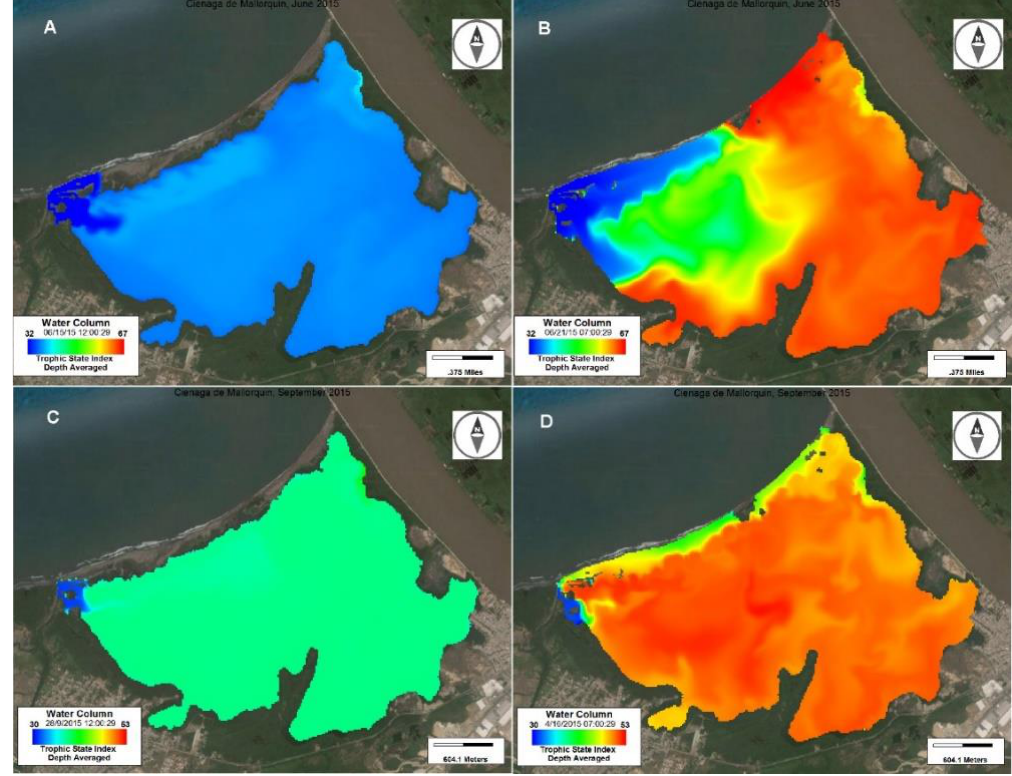
Fig. 10: Simulation of TSI variation. A) Transition Period (0.5 days of simulation). B) Transition Period (6 days of simulation). C) Wet season (0.5 days of simulation). D) Wet season (6 days of simulation) (wet season: note the change in scale values).